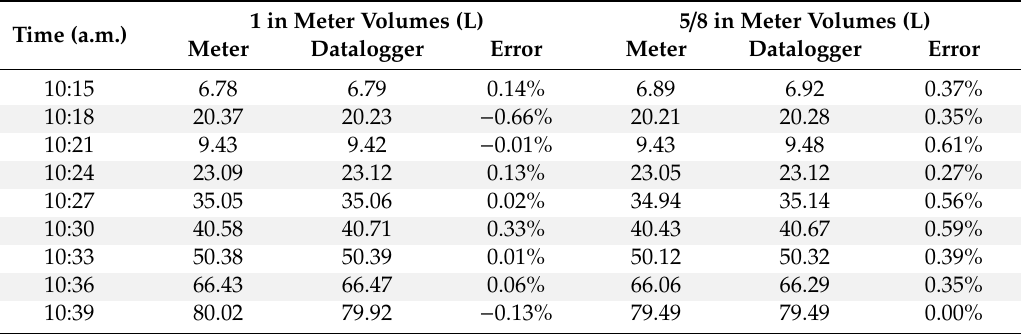
Table 7. Results from Experiment 2 for the 1 and 5 / 8 in Master Meter. Time